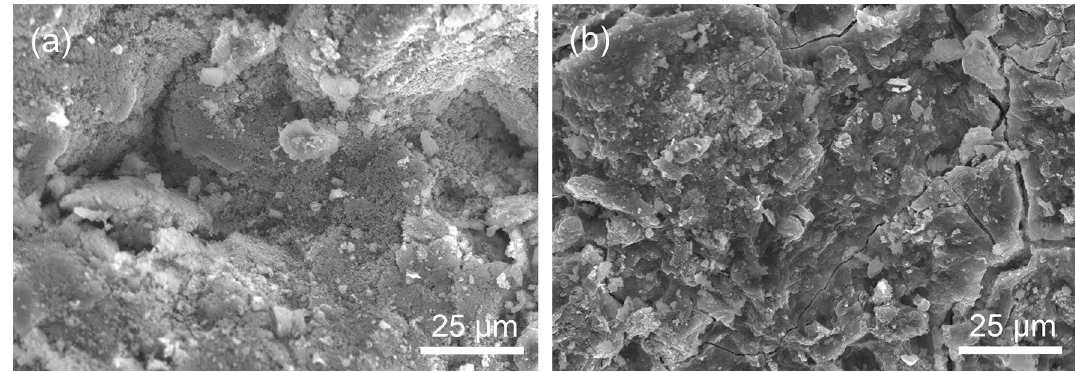
Figure 5. SEM images of 3:7 particles with ( a ) 0% and ( b ) 10% Na 2 CO 3